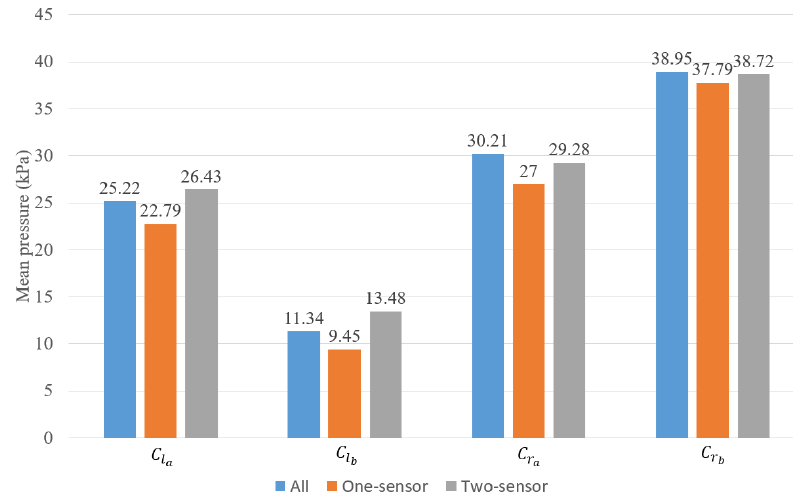
Figure 14. Validation of the mean